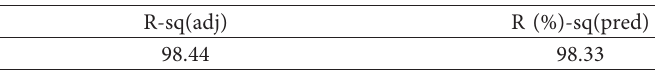
Table 4: Model summary.